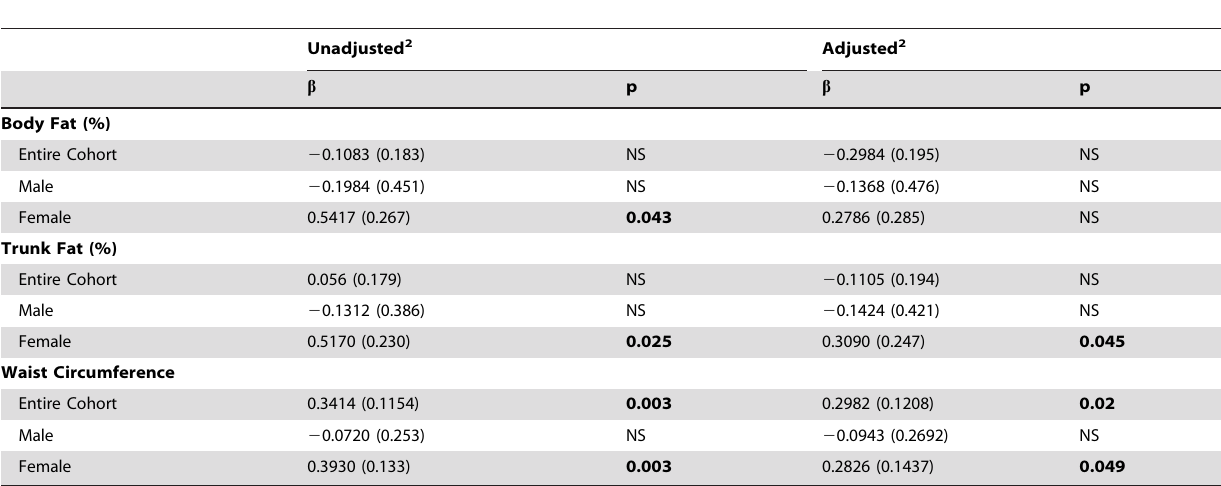
Table 6. Multiple Regression for Body Fat (%), Trunk Fat (%), and Waist Circumference (cm) on PYY Concentration 1,3 .